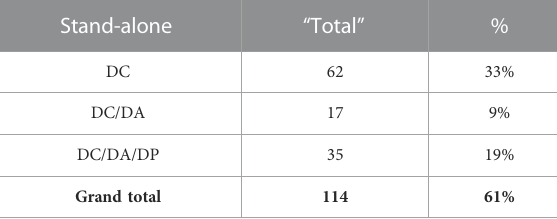
TABLE 5 Distribution of data stages in stand-alone technologies.